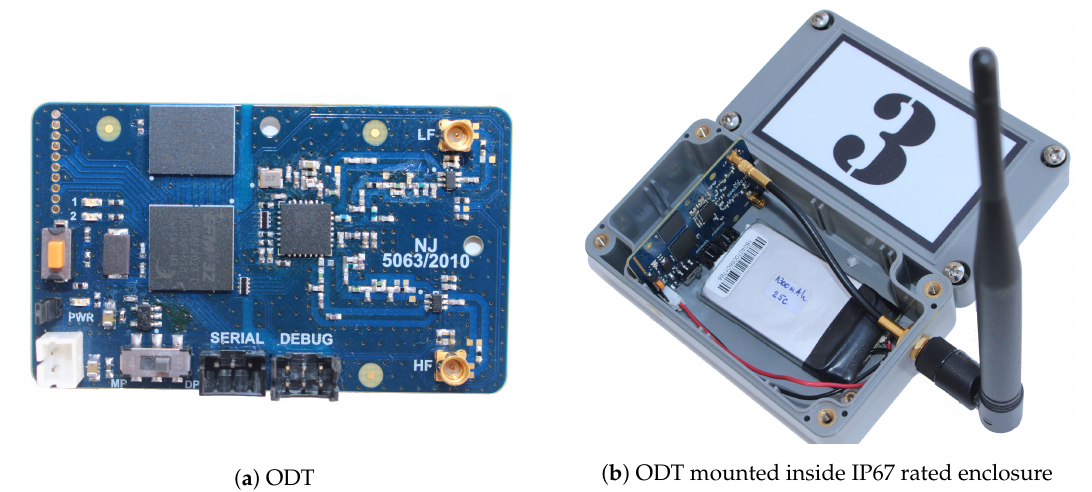
Figure 3. Physical appearance of: ( a ) ODT, ( b ) device deployed in the field experiments.